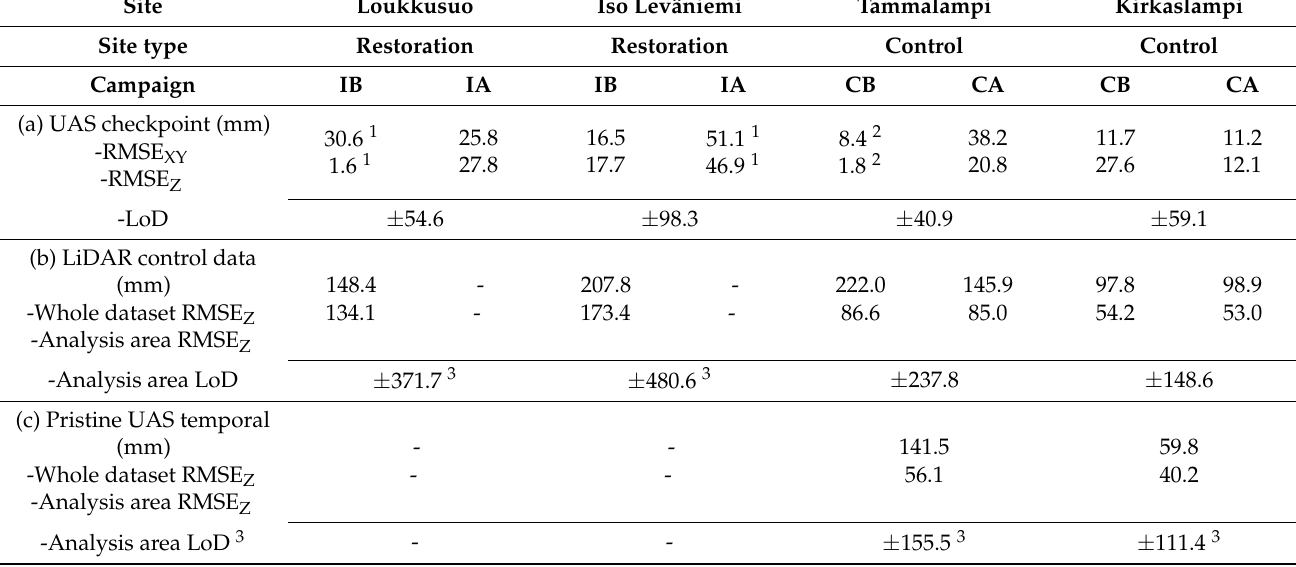
Table 3. The georeferencing accuracy of the UAS data for the Intervention Before (IB) and After (IA) campaigns at the restoration sites, and their control campaigns (CB and CA) at the pristine sites from three aspects. The field-surveyed checkpoint co-ordinates were compared with those modelled in the SfM process (a). Sparse airborne LiDAR control elevations were compared pointwise with the SfM data (b). Rasterized elevations from two UAS campaigns were compared with each other at the sites where no anthropogenic structure changes occurred